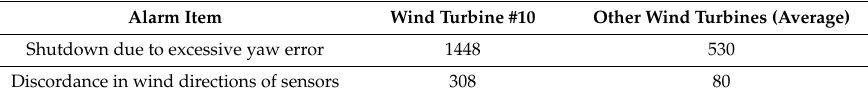
Table 2. Number of alarm occurrences for wind conditions under all wind directions.